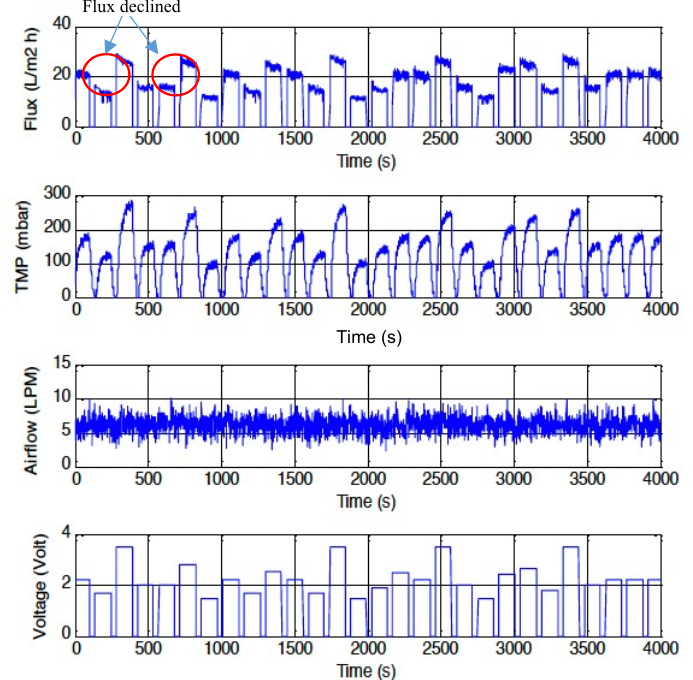
Figure 4. Input and output data for the SMBR filtration process: The input is the permeate pump voltage while the outputs are the flux and TMP. The aeration airflow during filtration is set around 6 to 8 L per minute (LPM) to maintain high intensity of bubble flow in cleaning the membrane.